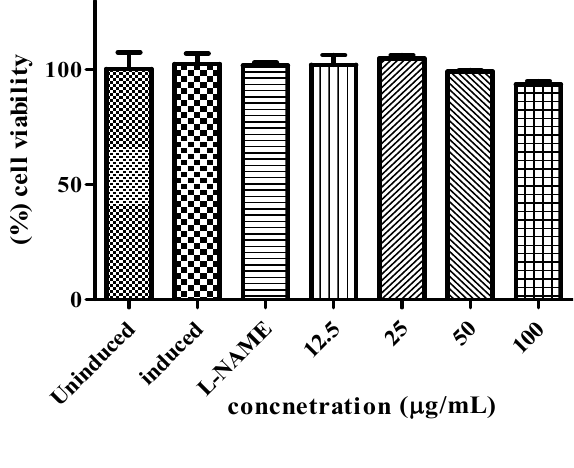
Figure 7. Effect of the C. aurantium extracts on cell viability of RAW 264.7 cells. Each bar represents the mean ± standard error of mean from three independent